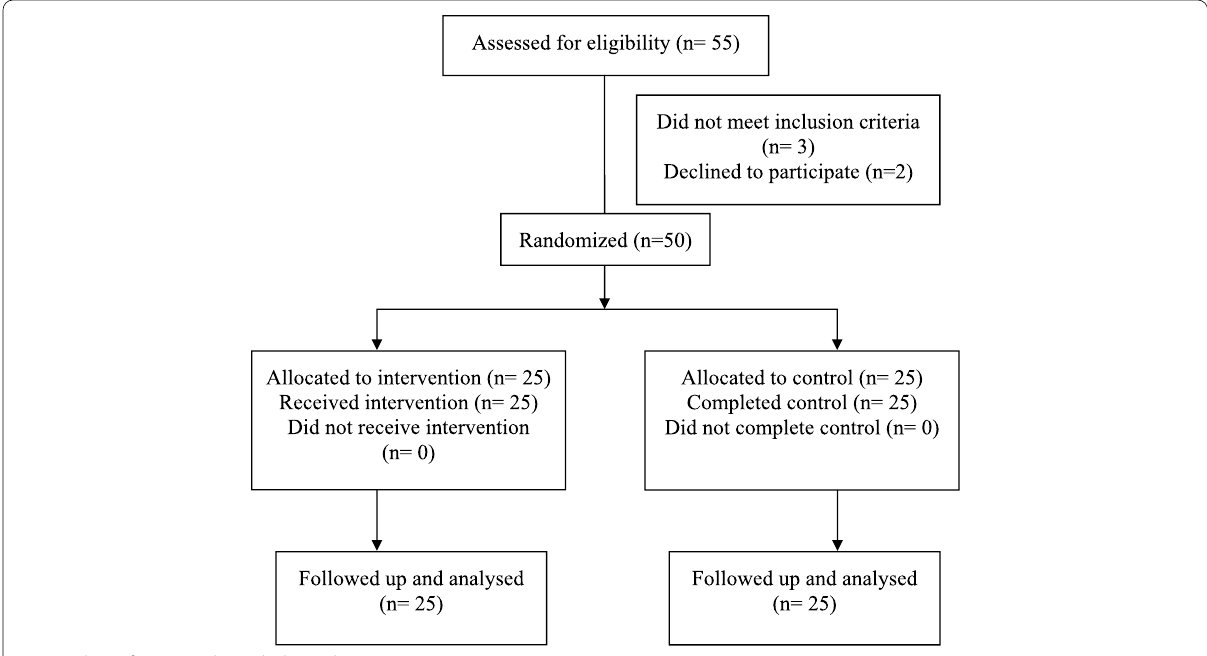
Fig. 1 Flow of patients through the